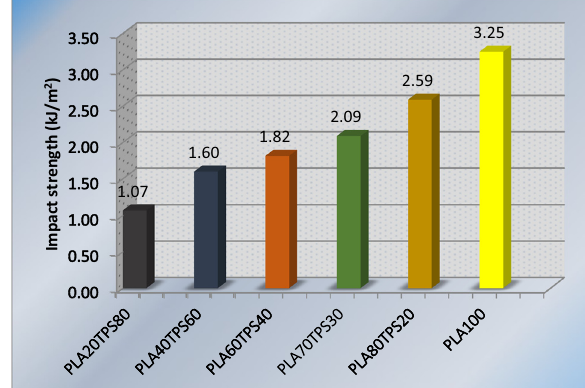
Figure 4: The Izod impact strength of PLA100 and neat PLA/TPS blend